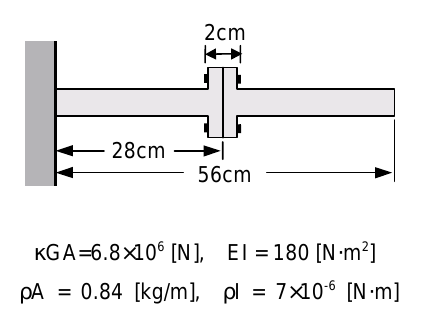
Fig. 1. A cantilevered beam structure with a bolt-joint in the midway.